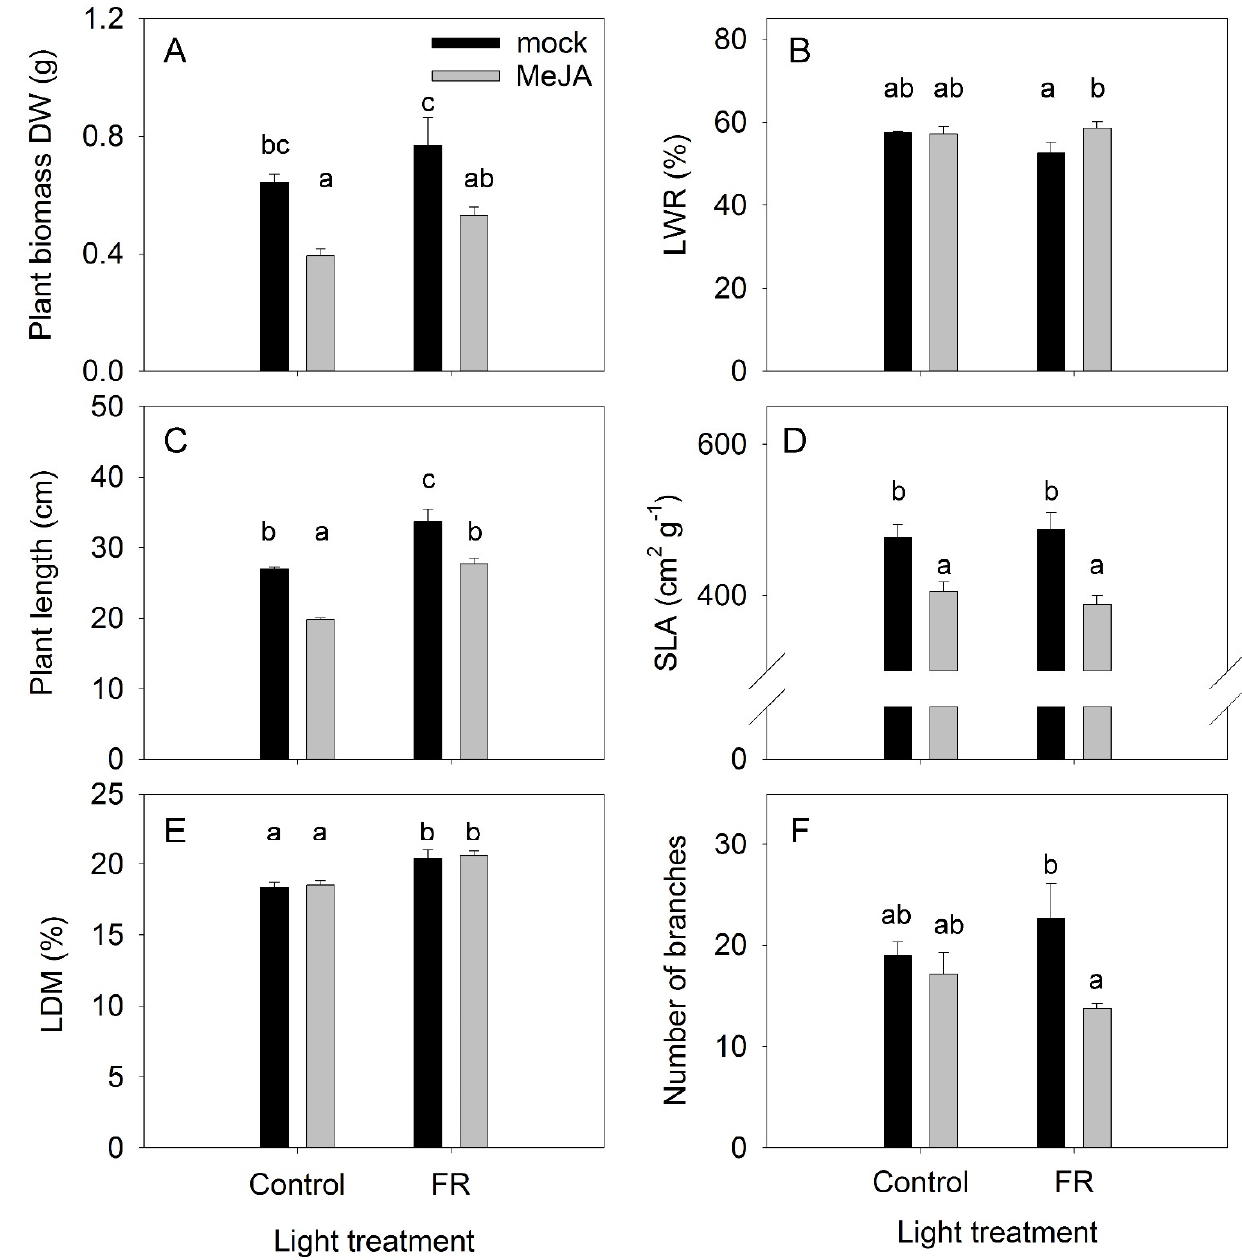
Figure 1. The effect of far-red light and methyl jasmonate (MeJA) application on plant biomass ( A ) leaf weight ratio (LWR) ( B ) plant length ( C ) specific leaf area (SLA) ( D ) leaf dry matter content (LDM) ( E ) and number of secondary branches ( F ) in Hypericum perforatum ( n = 6). Differences between means with different letters are statistically significant. H. perforatum seedlings were given different light and hormone treatments at 36 days after sowing (DAS). The final plant samples were taken at 65 DAS.